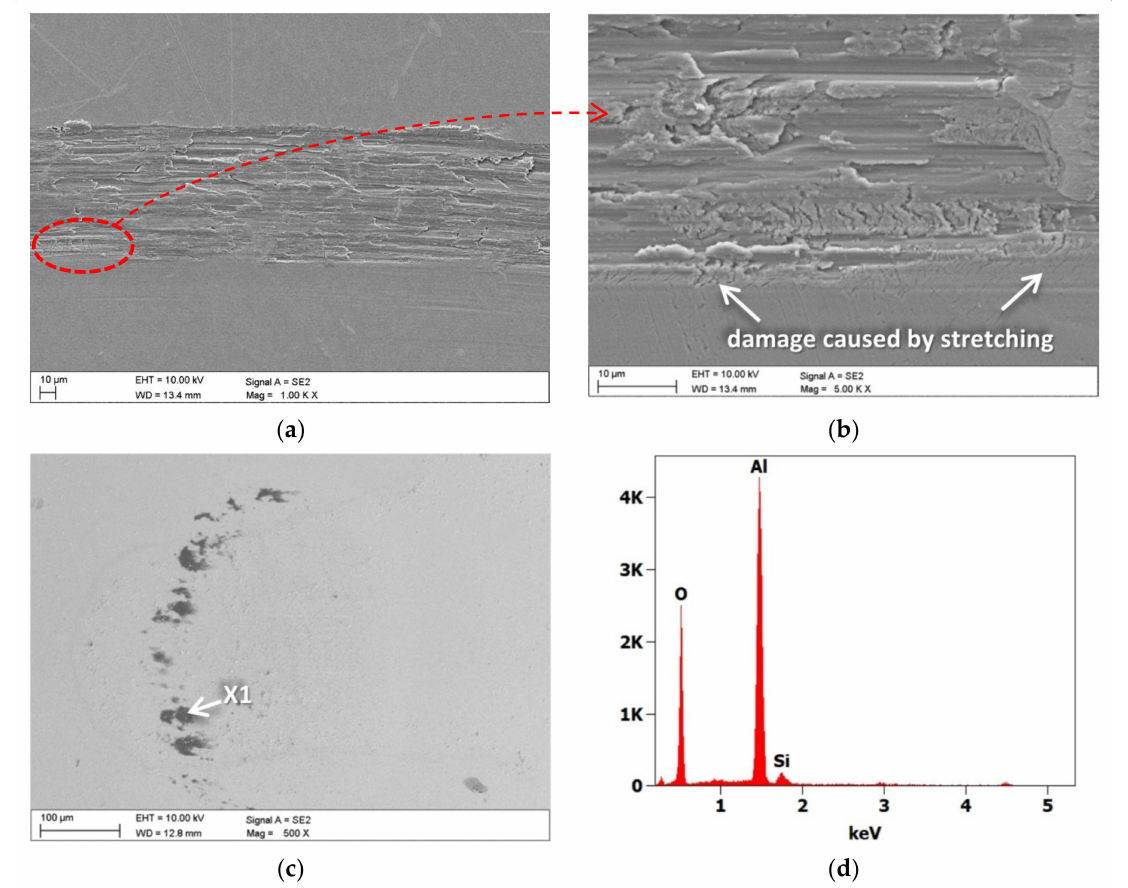
Figure 12. ( a , b ) Wear trace after the “ball-on-disc” wear test for TiO 2 /nanoTiO 2 bimodal coatings, ( c ) wear place after the “ball-on-disc” wear test for cemented carbide ball as a counter-sample, and ( d ) X-ray energy dispersive plot of the area X1 in ( c